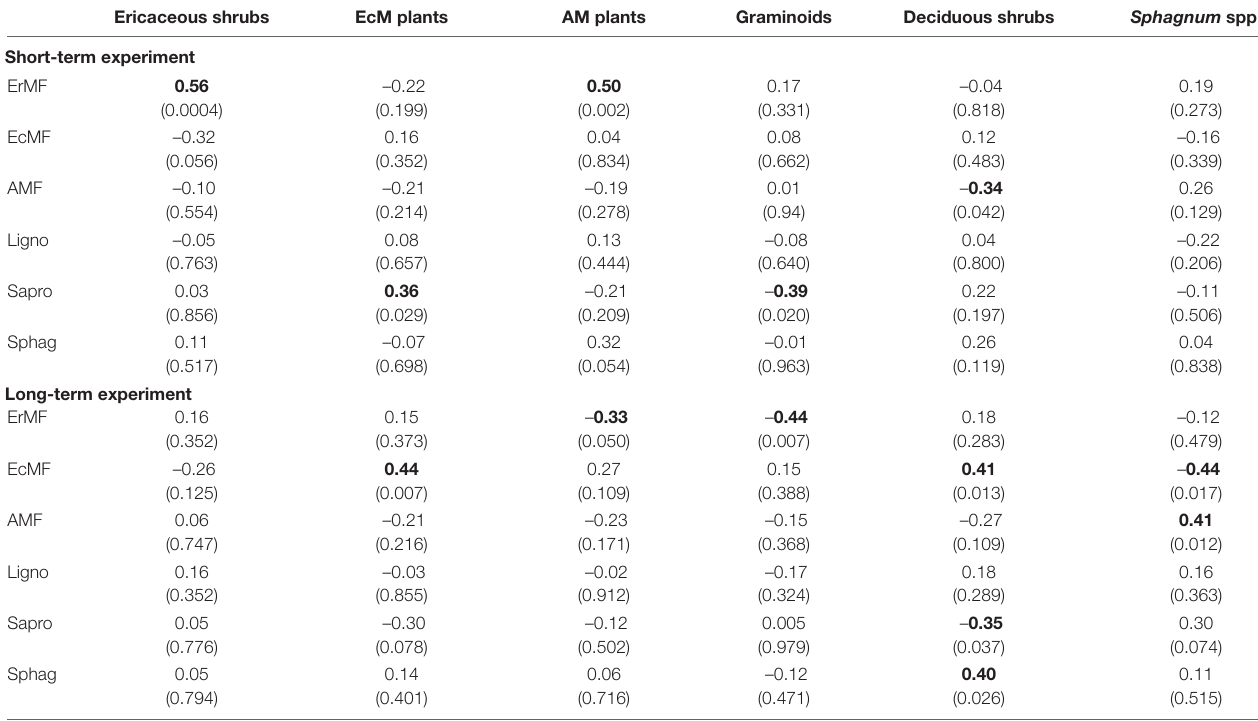
TABLE 3 | Spearman’s correlation between the relative abundance of different fungal functional guilds and abundance of different plant functional types. Ericaceous shrubs EcM